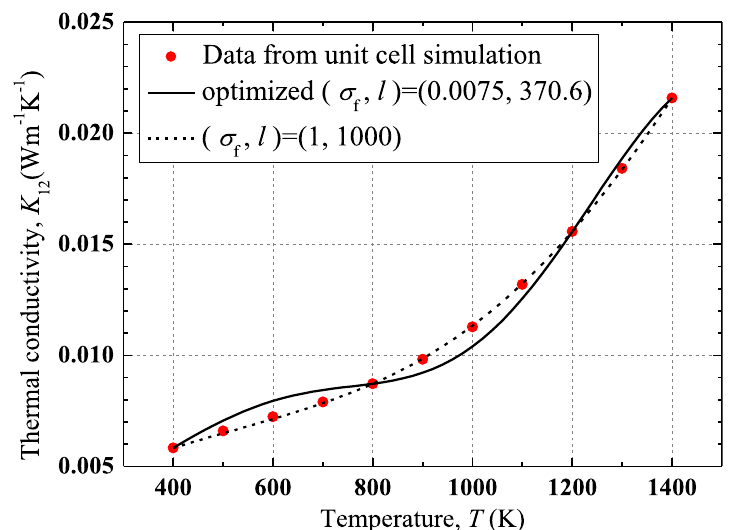
Fig. 2 Gaussian process regression model with different ( σ f , l )